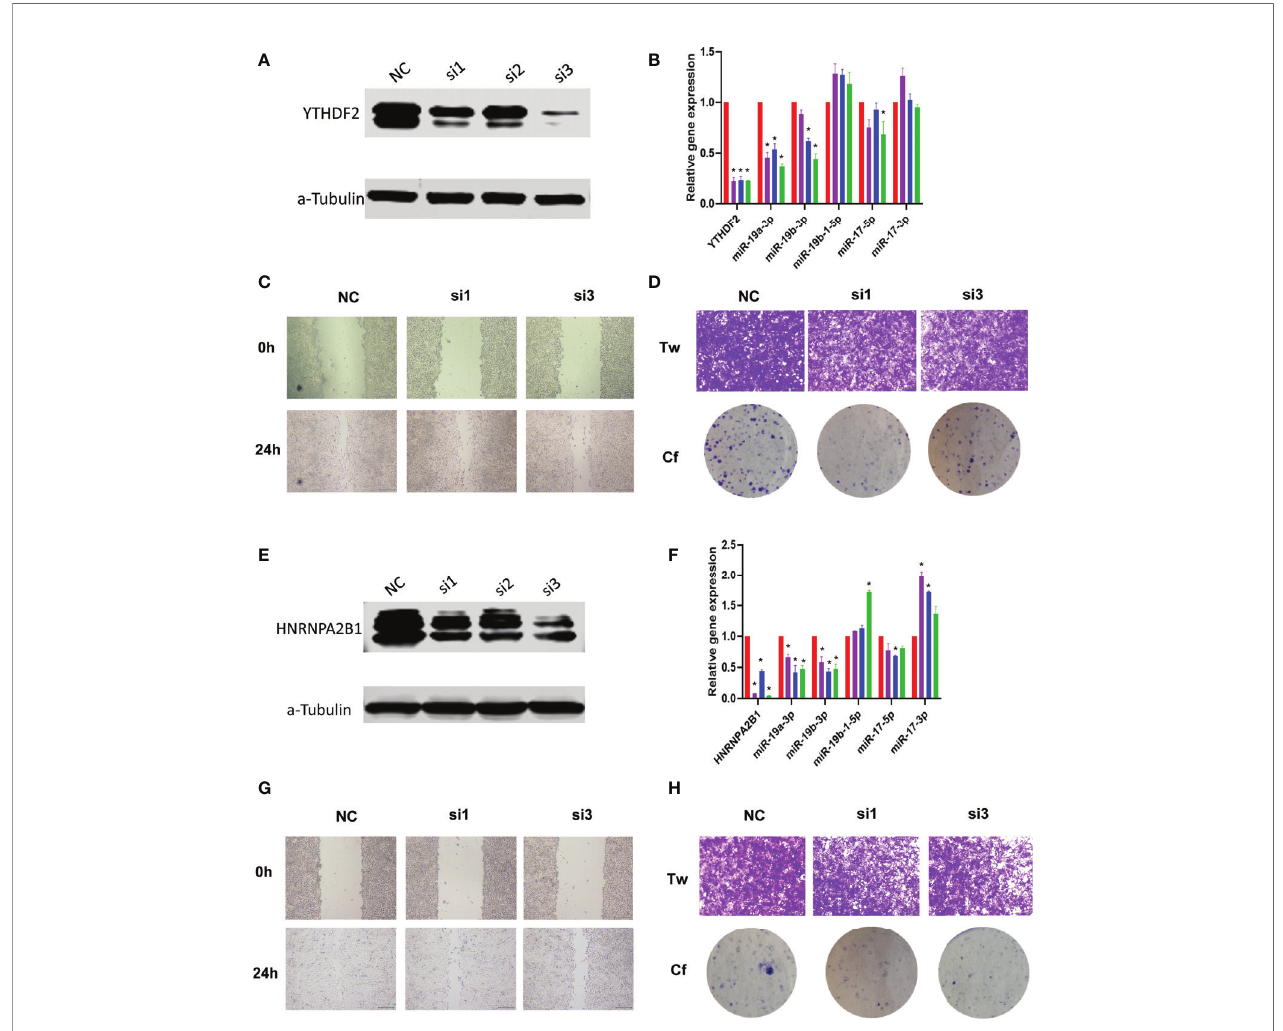
FIGURE 6 | Loss offunction experiments of m6A regulators in osteosarcoma cells line. (A) Expression of YTHDF2 in knockdown groups via western blot. Here we used three candidate siRNAs to target YTHDF2. (B) Expression of YTHDF2 and target miRNAs in knockdown groups via Real-time PCR. * represents p <0.05 vs. NC group, N=6. (C) Wound healing experiment results of YTHDF2 knockdown. Here we used siRNA#1 and siRNA#3. (D) Transwell and clone formation experiments results of YTHDF2 knockdown. Here we used siRNA#1 and siRNA#3. (E-H) Expression, wound healing, transwell and clone formation experiments of HNRNPA2B1